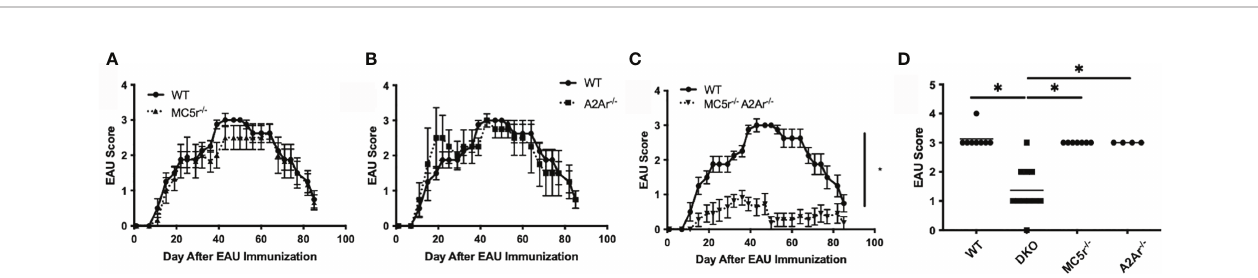
FIGURE 3 | The course of EAU in WT, MC5r -/- , A2Ar -/- , and DKO mice. WT mice (n = 8), MC5r -/- (n = 7), A2Ar -/- (n = 4), and DKO (n = 11) mice were immunized for EAU and evaluated from the time of immunization every 3 - 4 days for clinical signs of uveitis. The course of disease MC5r -/- ( A , dashed line with triangles), A2Ar -/- ( B , dashed line with squares), and DKO ( C , dashed line with inverted triangles) is shown with WT mice (solid line with circles). The severity of disease is indicated by the maximum score of each mouse over the entire course of disease (D) . Each experiment consisted of 1-4 mice, and each experiment was repeated 2-3 times. Signi fi cance was assessed by two-way ANOVA with Bonferroni post-test for EAU scores over the course of disease and nonparametric Mann-Whitney U test for maximum scores. Statistical signi fi cance (P ≤ 0.05) is designated by